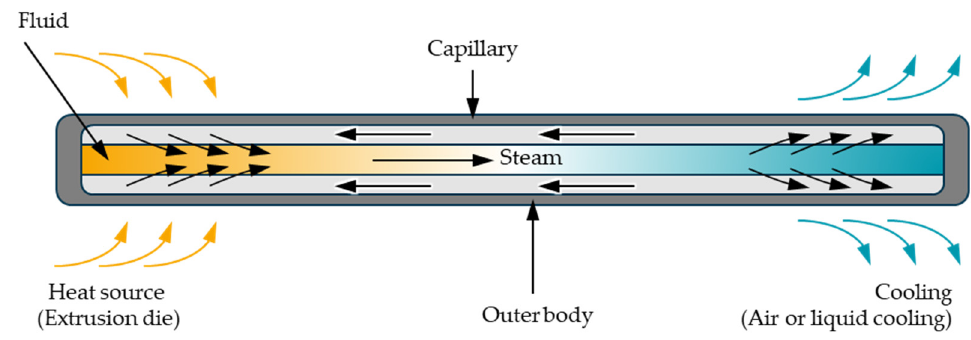
Figure 2. Schematic of a heat pipe.